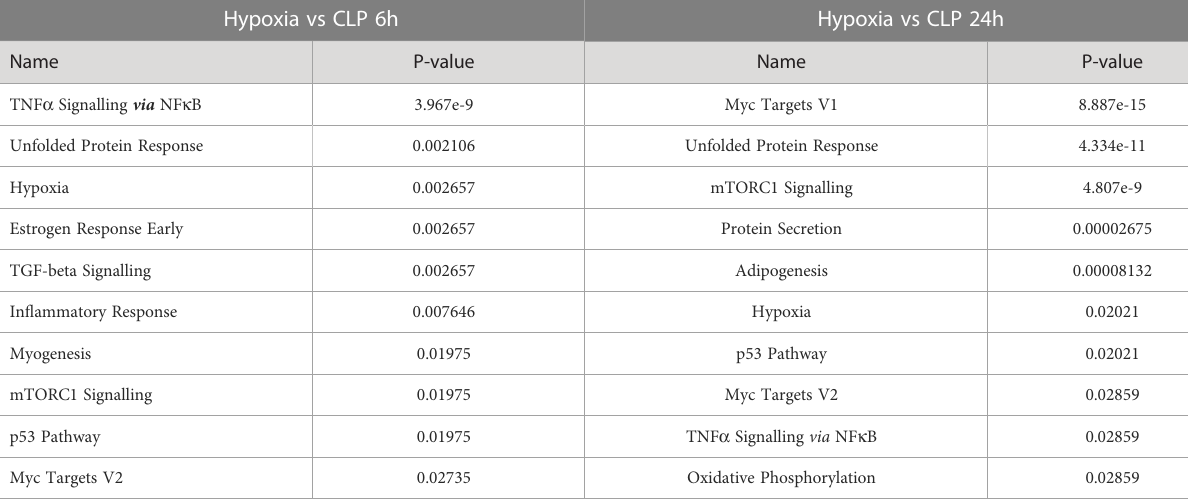
TABLE 3 Enrichr analysis of upregulated genes shared between hypoxia and